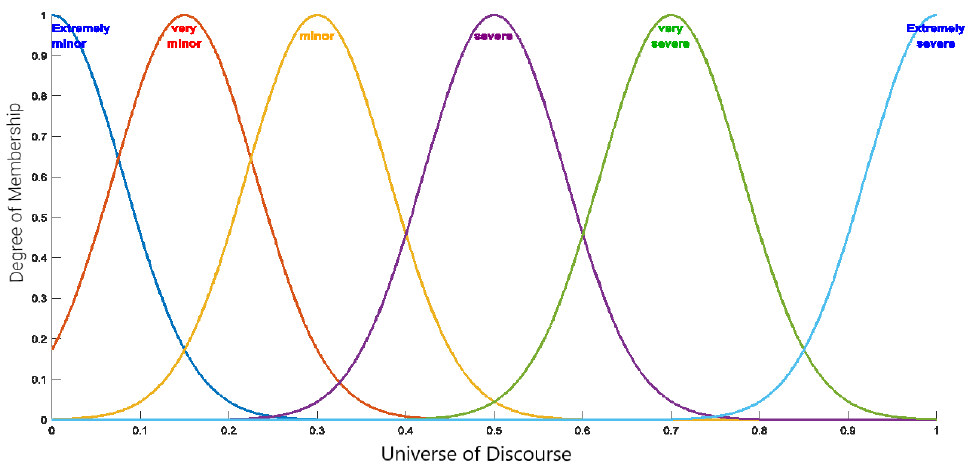
Figure 3. Membership functions associated with RA severity